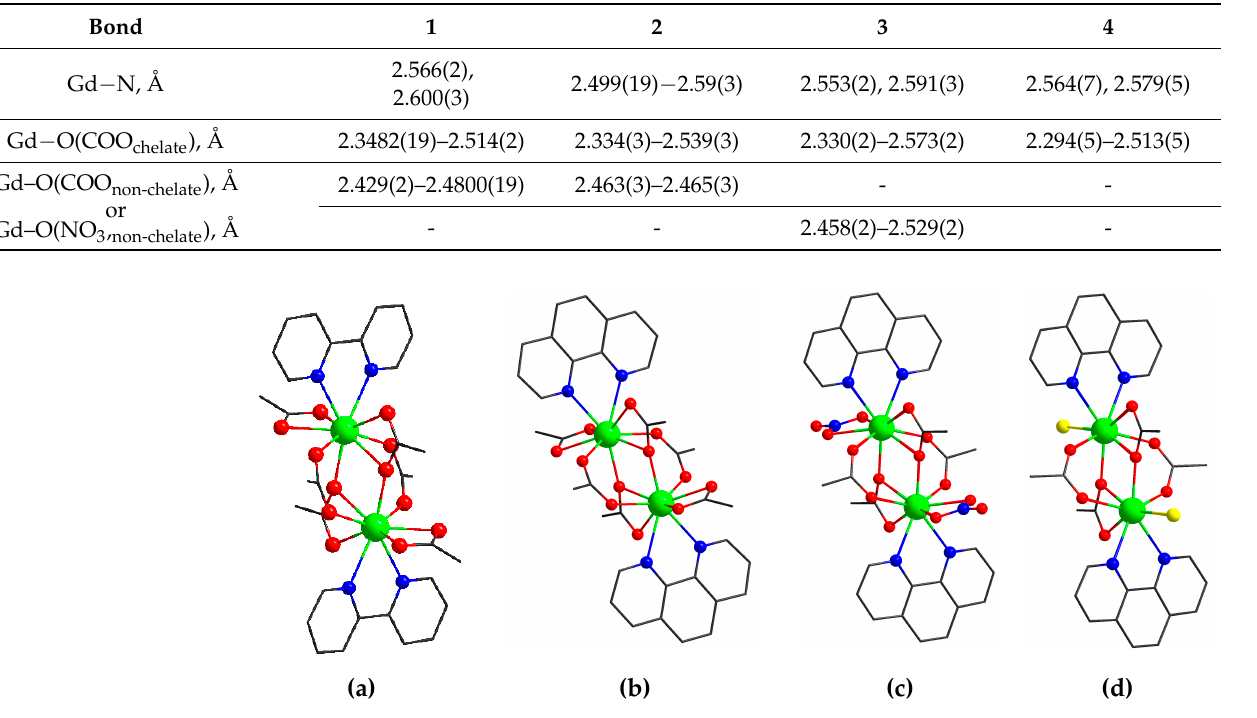
Figure 1. Secondary building units in 1 ( a ), 2 ( b ), 3 ( c ) and 4 ( d ). Gd atoms are green, N atoms are blue, O atoms are red, Cl atoms are yellow. H atoms are not shown.